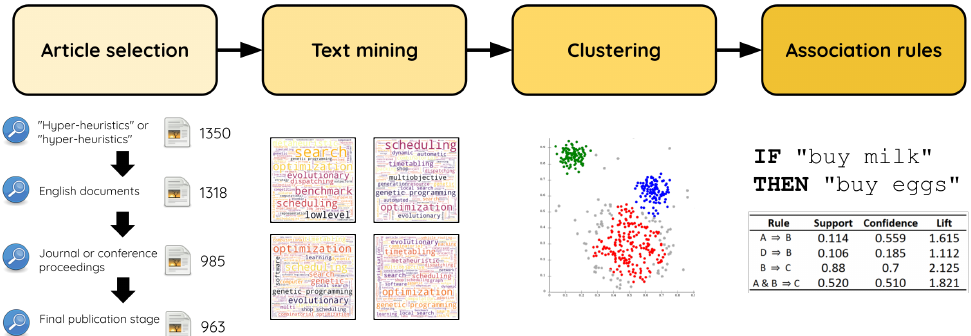
Figure 1. Graphical description of the four-stage methodology followed in this